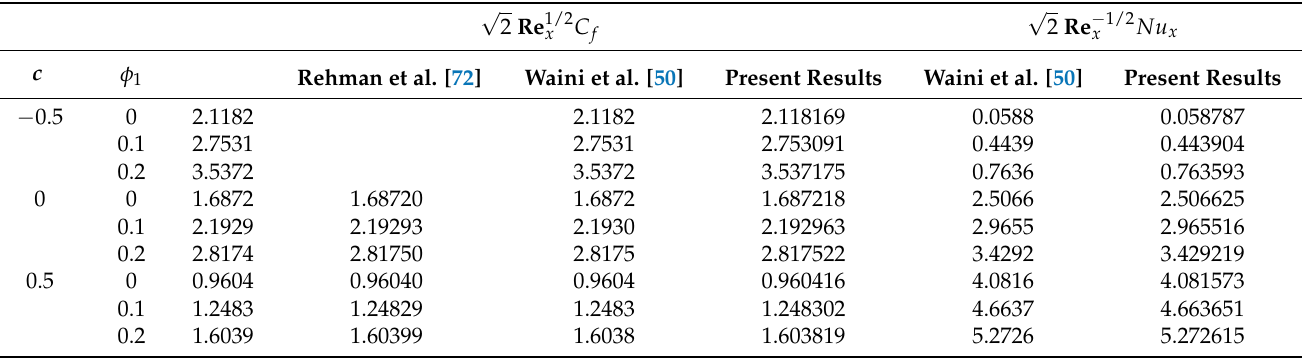
Table 3. Comparison values of various values of c and φ 1 when λ = 0, Pr =